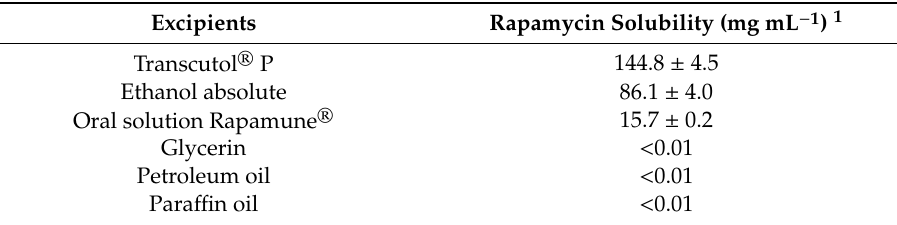
Table 2. Rapamycin solubility in the solvents used and formulations at 25 ◦ C.